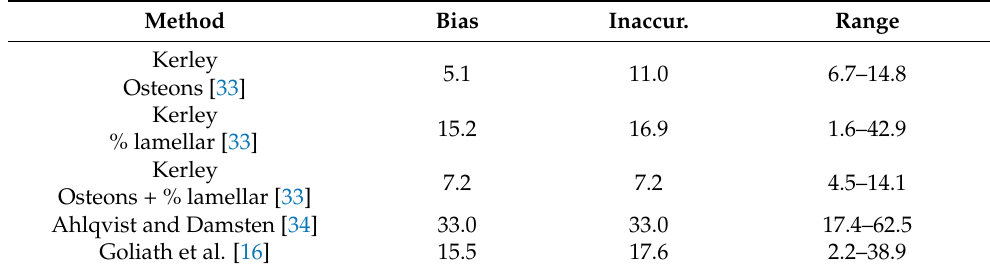
Table 10. Bias, inaccuracy and error range of the age estimates generated by the femur methods.